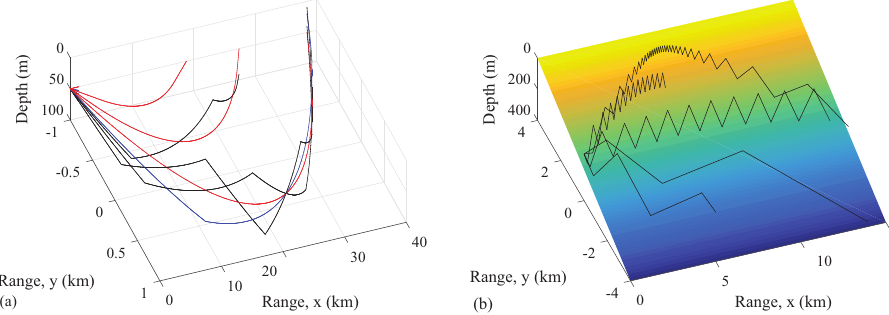
Figure 3. ( a ) Effect of a nearby oceanic front and ( b ) effect of a wedge seabed on horizontal refraction of the acoustic